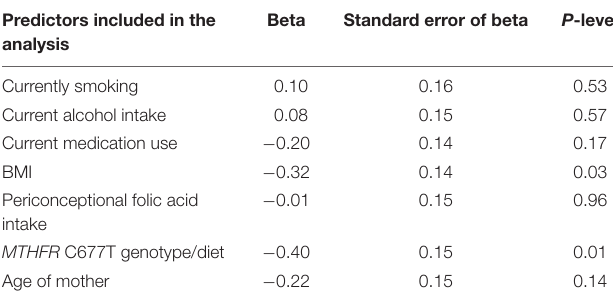
TABLE 4 | Multivariate analysis of predictors that influence LINE-1 methylation in mothers of children with DS with congenital heart defects